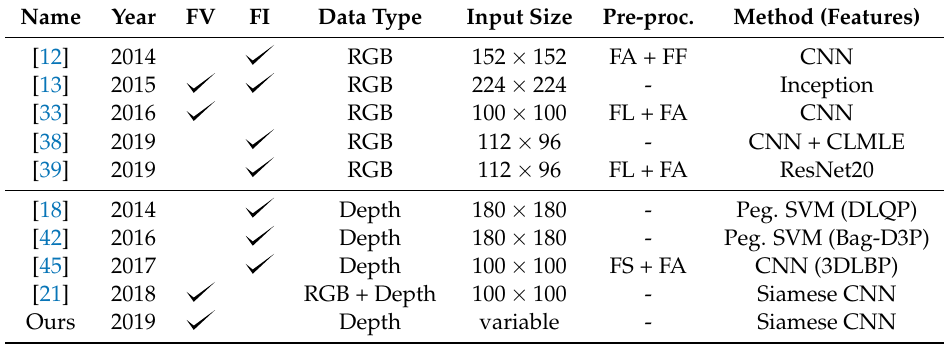
Table 1. Summary of the main methods for Face Identification (FI) and Verification (FV) in the literature. In addition, for each method, we report the year of publication, the type and size of the input data, the pre-processing steps (Pre-proc.) required in terms of a priori required procedures (FA: Face Alignment , FL: Facial Landmarks , FF: Face Frontalization , FS: Face Segmentation ), excluding the face detection and crop actions, since they are generally adopted by all the investigated